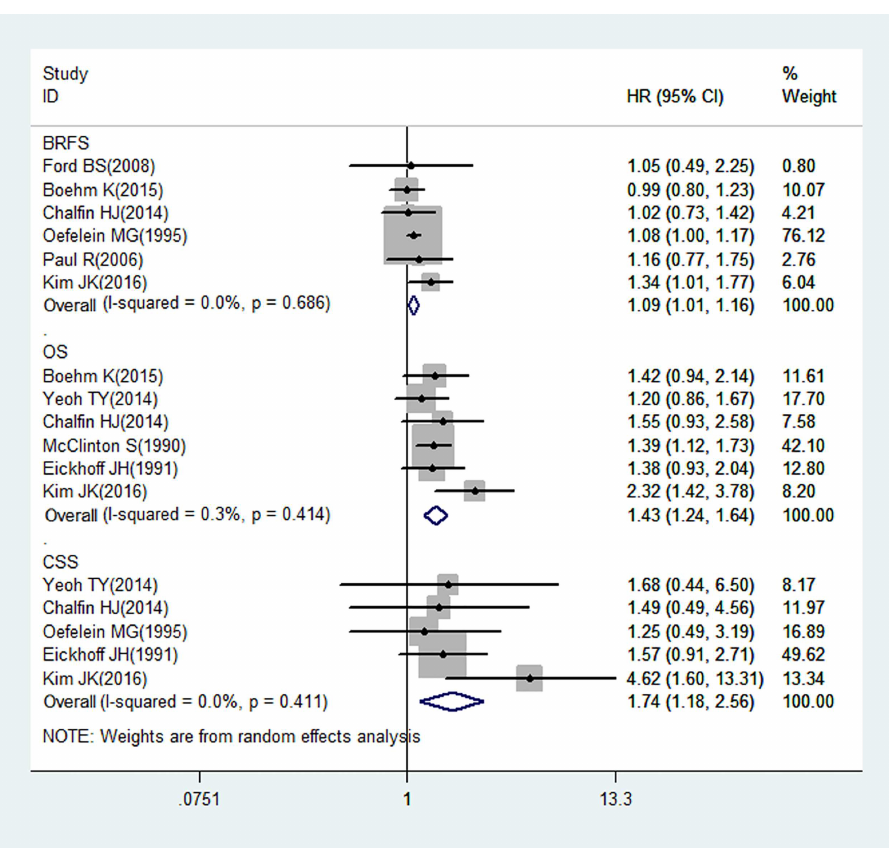
Fig 3. Random-effects model forest plots showing the impact of allogeneic BT on the survival of PCa patients after RP.